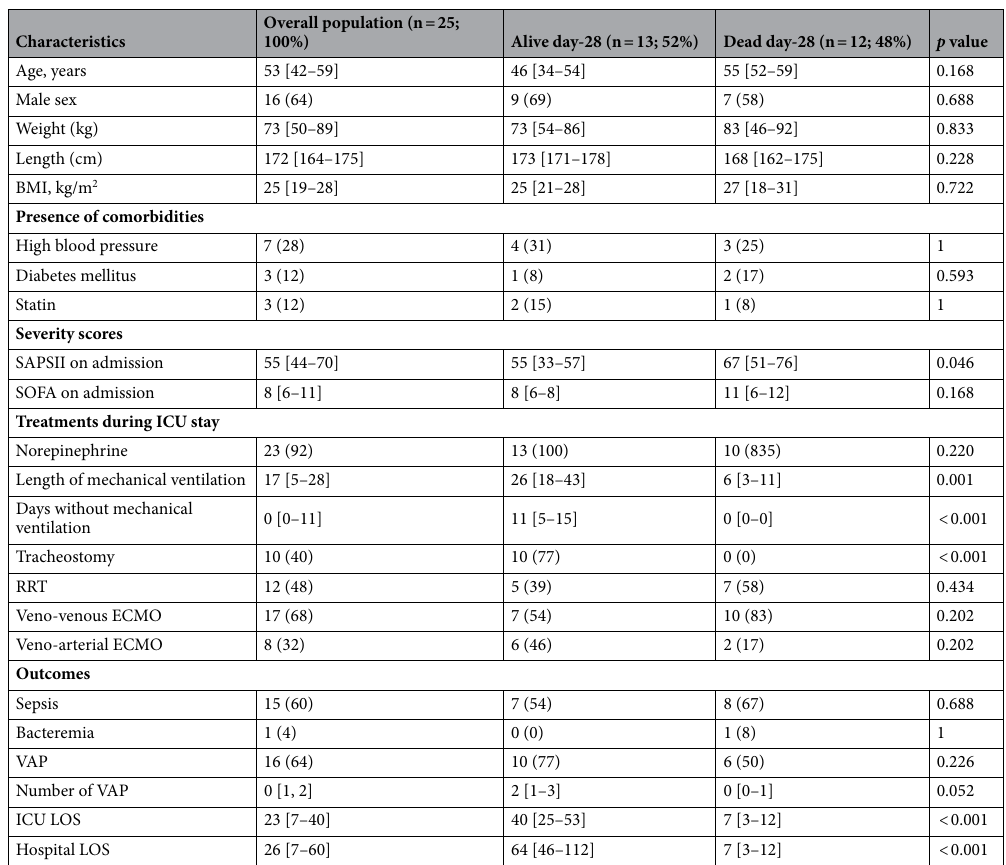
Table 1. General characteristics and outcomes of the patients. Continuous variables are expressed as the median and interquartile range (IQR) and were compared using the Mann–Whitney U test. Categorical variables are expressed as n (%) and were compared with Fisher’s exact test; BMI: body mass index; ECMO: extracorporeal membrane oxygenation; LOS: length of Stay; RRT: renal replacement therapy; SAPS II: simplified acute physiology score II; SOFA: sepsis-related organ failure; VAP: ventilator-associated